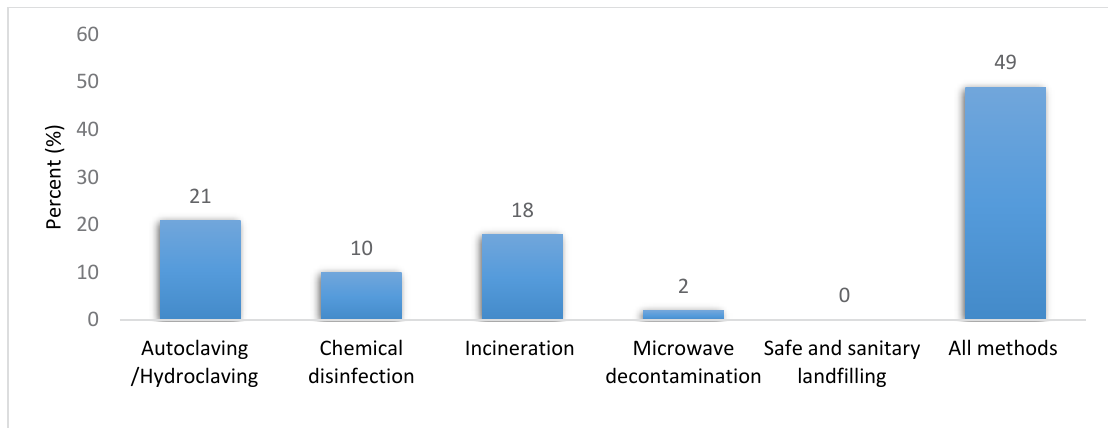
Figure 3. Prioritization of methods that require specialized personnel for